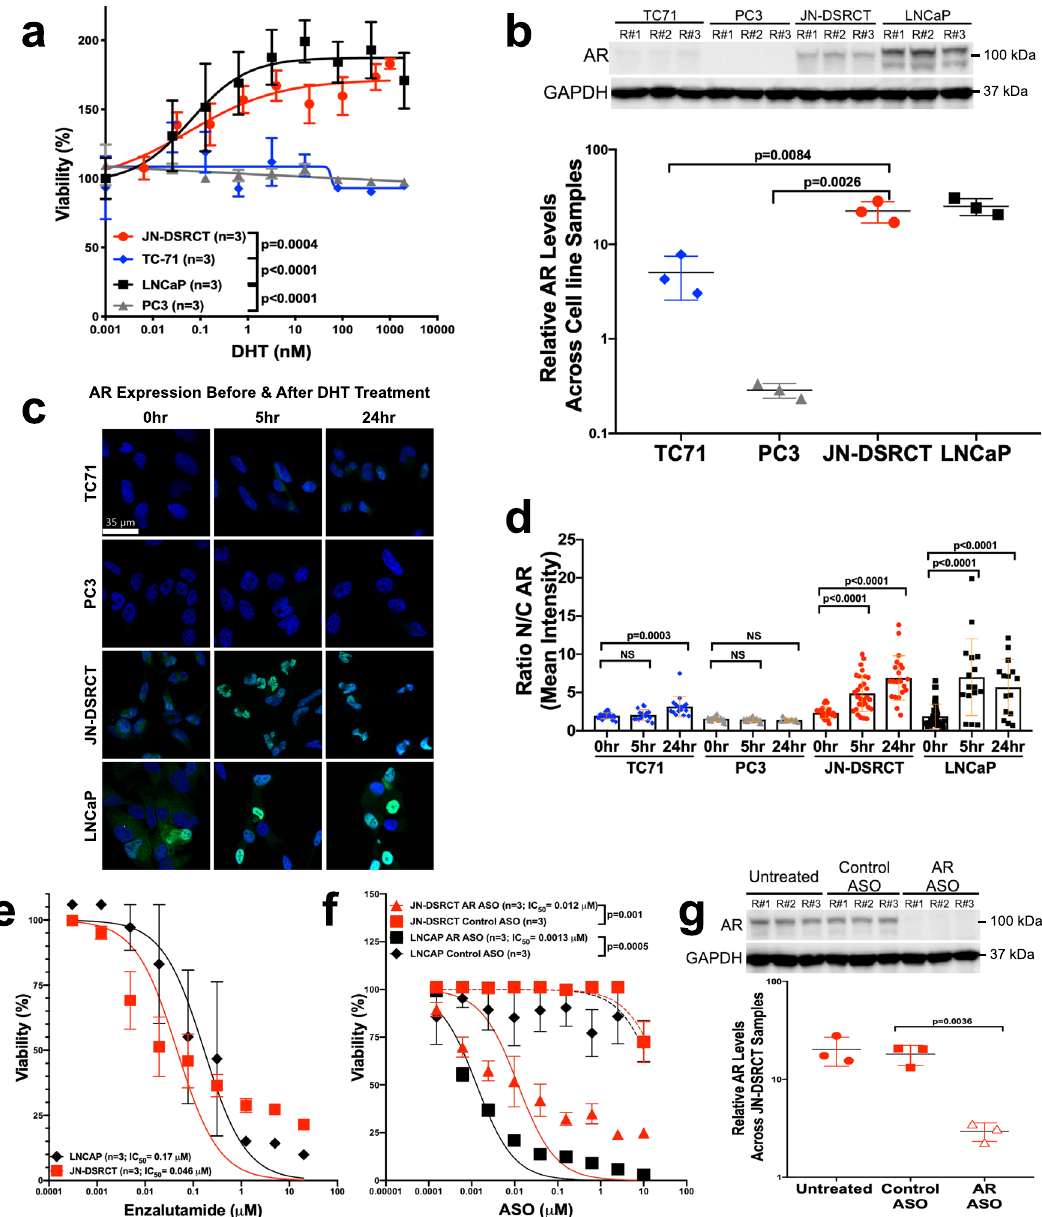
Fig. 4 In vitro stimulation and inhibition of DSRCT proliferation via AR. a JN-DSRCT, TC71, LNCaP, and PC3 cell proliferation assays after treating them with an AR agonist hormone, dihydrotestosterone (DHT) in a dose-dependent manner. n is the number of experimental replicates. b Pro fi ling JN-DSRCT, TC71, and LNCaP cells for their AR expression by western blotting and histogram presentation of relative AR levels across each cell line. c Pro fi ling of JN- DSRCT cells for AR protein expression (green) by immuno fl uorescence analysis with DAPI-labeled nuclei (blue), d Quantitative scatter plot representation of the ratio Nuclear/Cytoplasmic AR mean intensity reported within a single cell at 0, 5 and 24 h of DHT post-treatment. e JN-DSRCT cells are relatively less sensitive to enzalutamide than ( f ) AR antisense oligonucleotides treatment, as shown by the in vitro WST1-Proliferation cell-based assay. g Western blot analysis of AR expression in JN-DSRCT cells untreated or after Control-ASO and AR-ASO treatments. Histogram presentation of relative AR levels across each cell line after GAPDH normalization. Data points in a , e , and f represent mean ± SEM using three experimental replicates for each cell line. Data in b (bottom panel), d and g (bottom panel) represent mean ± standard deviation. P values calculated by unpaired two-tailed t